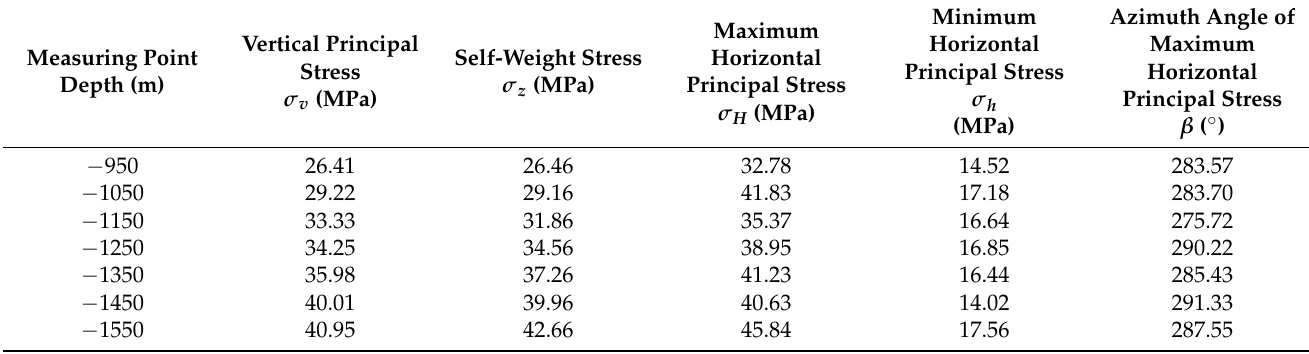
Table 2. In situ stress test